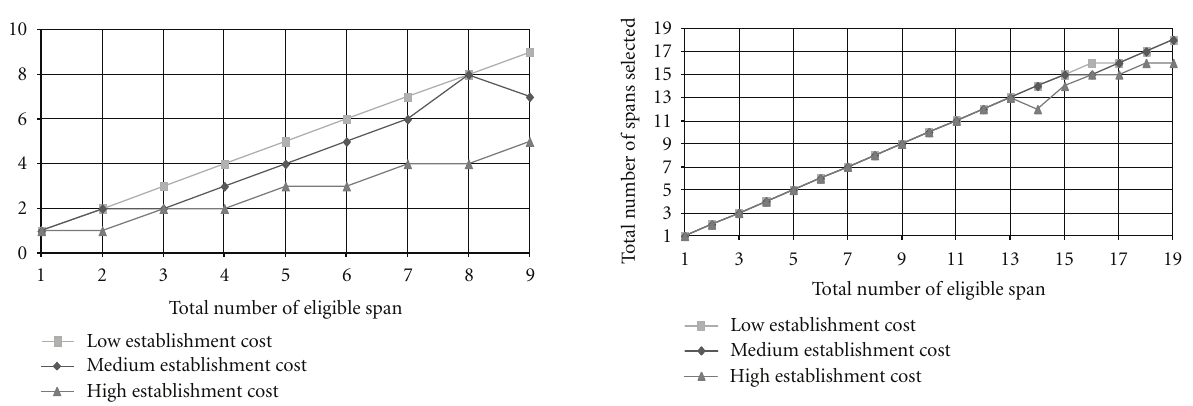
Figure 11: Variation of total number of selected spans for 20-node 40-span network.